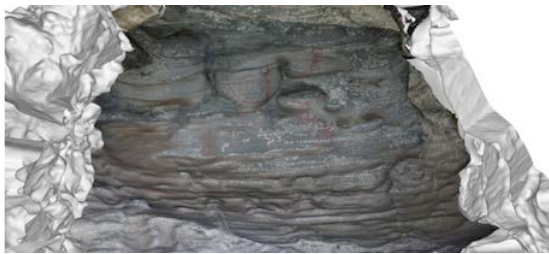
Figure 9. Orthopho processed from the textured 3D model 4.4 Vertical and horizontal sections processed from the point cloud Vertical section (Figure 10) and horizontal ones (Figure 11) have been generated from the point cloud. These CAD 2D drawings have been processed from the tools offered by the CloudCompare 2.6 software.